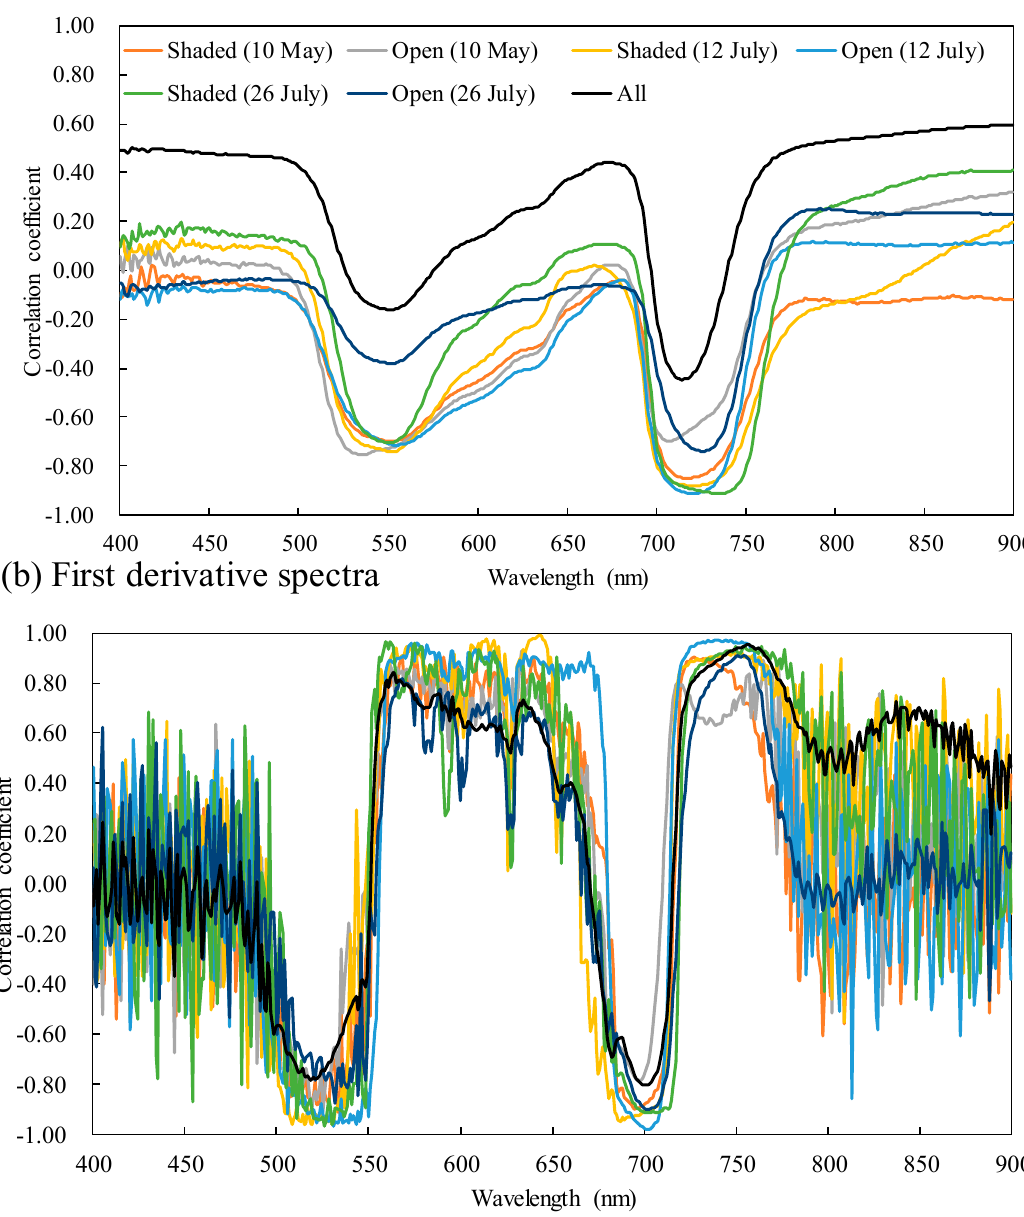
Figure 3. Correlations ( a ) between chlorophyll content and reflectance and ( b ) between chlorophyll content and first derivative spectra.